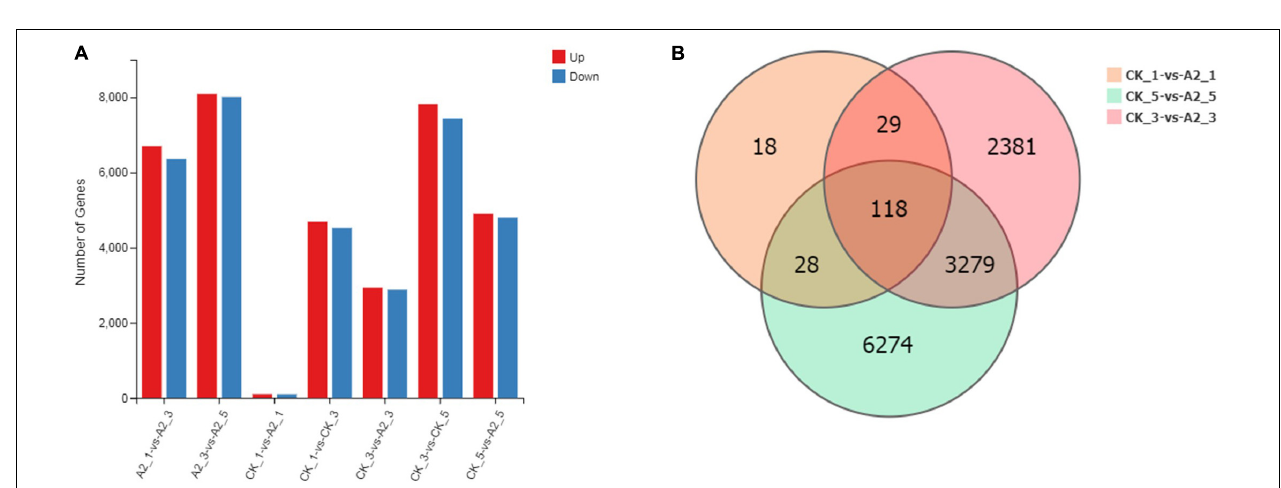
FIGURE 3 | A summary of DEGs between CK and A2. (A) Number of DEGs. (B) The Venn diagram of DEGs between CK and A2.